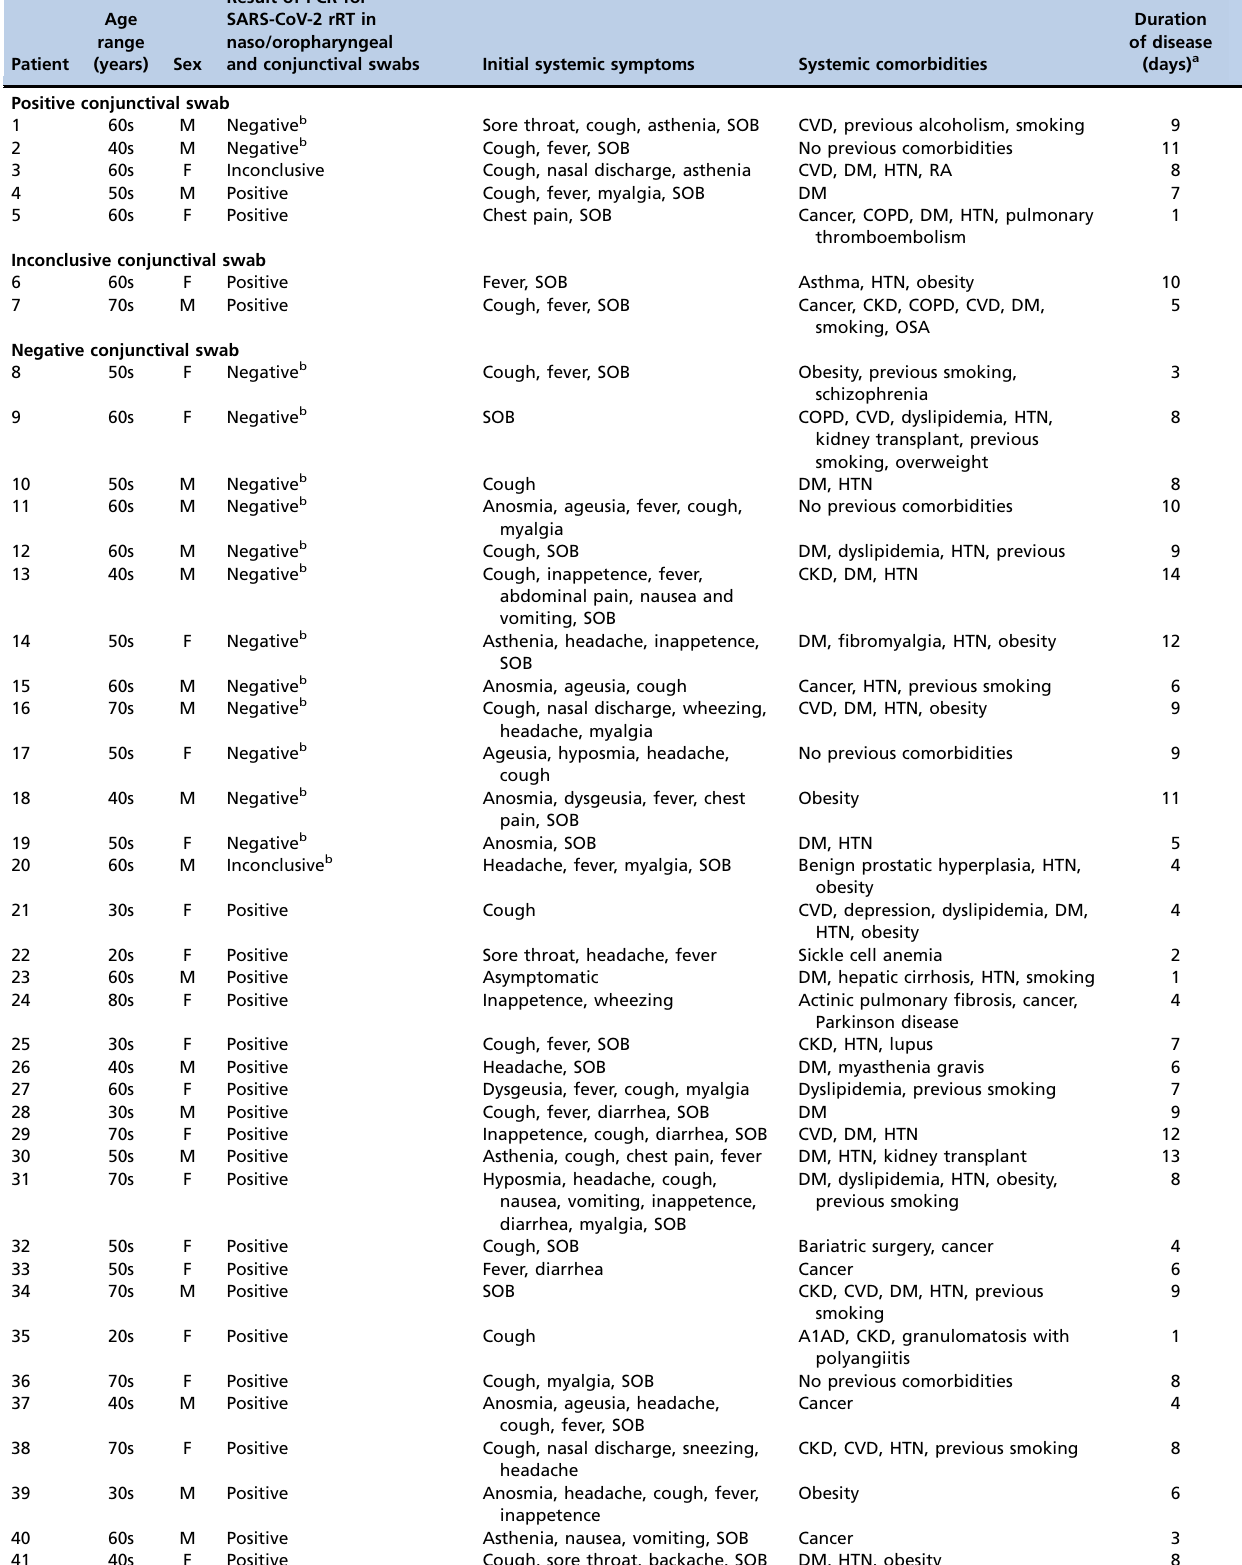
Table 1 - Demographic and clinical variables and SARS-CoV-2 RNA detection by rRT-PCR in naso/oropharyngeal and ocular swabs from 50 patients with severe or critical COVID-19.